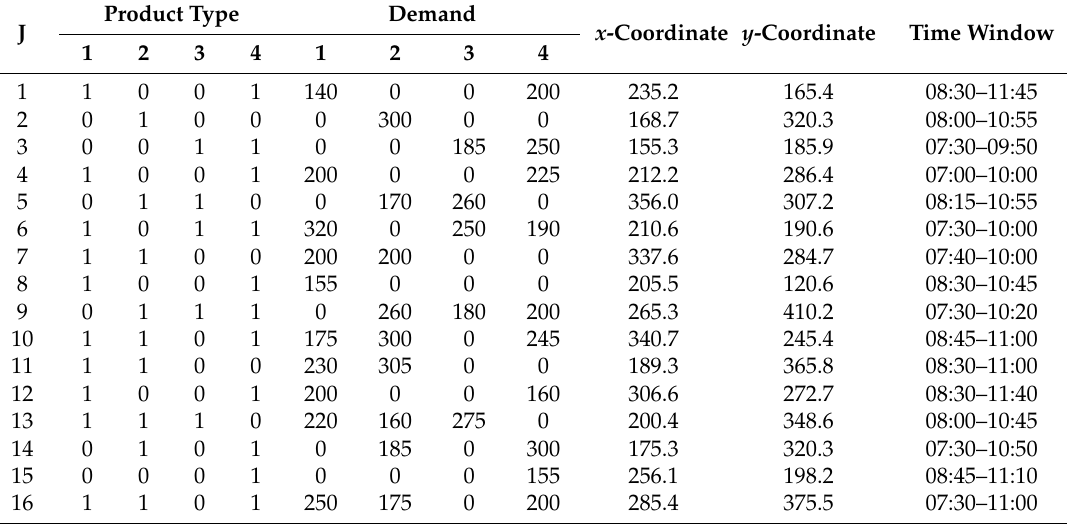
Table 5. The information of di ff erent demand